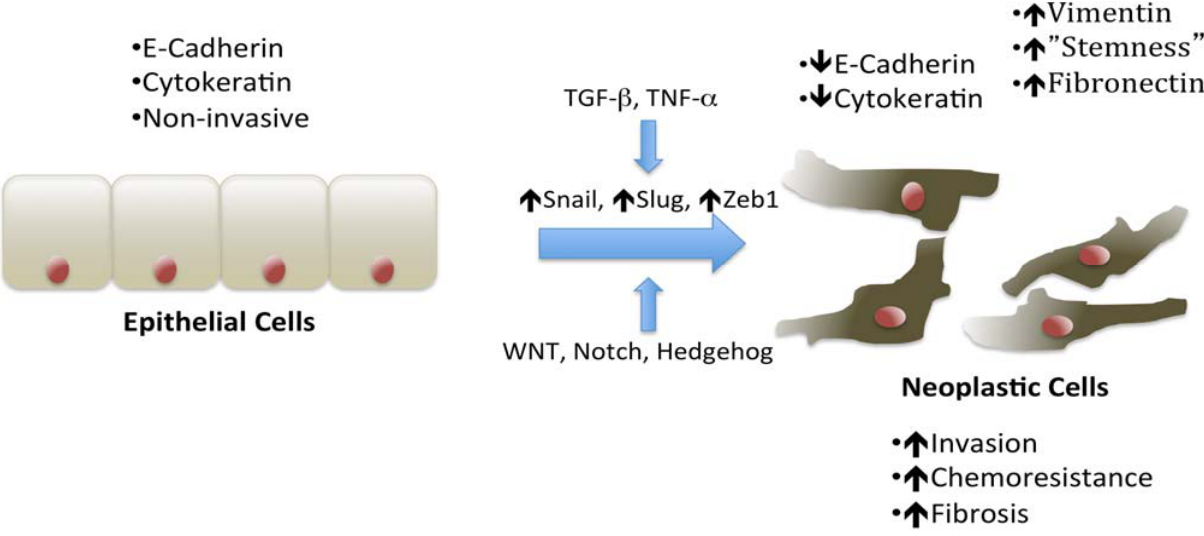
Figure 1. Schematic of epithelial to mesenchymal transition (EMT), including signaling pathways, transcription factors, and cell phenotype. Several cytokines and growth factors, notably TGF- β and TNF- α , along with the WNT, Notch, and Hedgehog pathways, induce EMT. The primary transcription factors in pancreatic cancer are Snail and Zeb1. Cell that undergo EMT lose their epithelial markers, such as E-cadherin and cytokeratin, and sheet like architecture and take on a mesenchymal phenotype with increased vimentin, fibronectin, and N-Cadherin expression along with single cell, spindle-like morphology. These cells can contribute to desmoplasia, are invasive, have stem-cell-like properties, and show increased